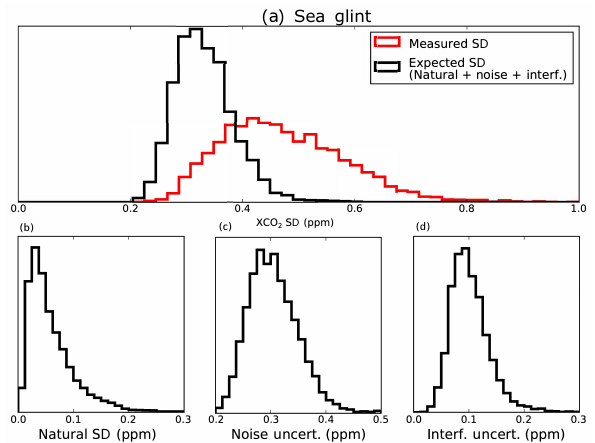
Figure A1. Distribution of all data used in this analysis for sea glint with no data quality flags used (all warn levels are used). (a) The expected (b, c, d) in black and the actual, bias removed, variabil- ity (red) line. The lower panels show the expected variability from natural sources (Appendix A), noise, and interferences.